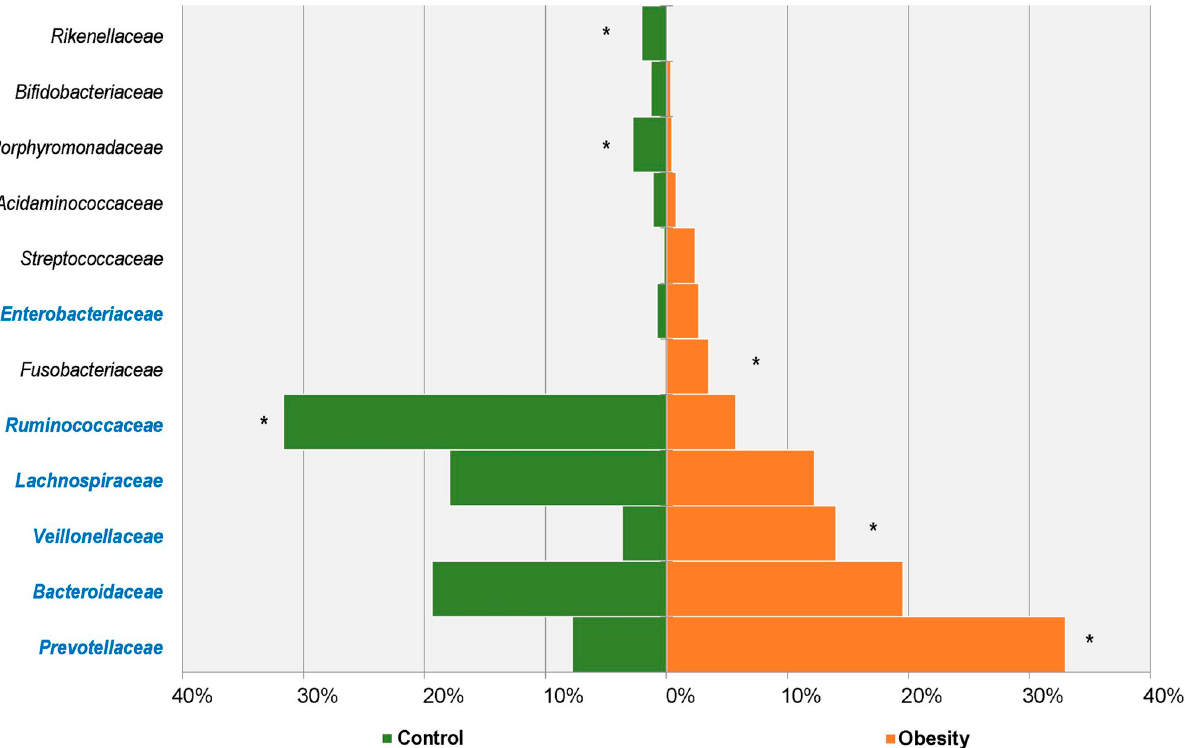
Fig 3. Major abundant families in Obesity and Control groups. The families with significant richness differences between the two groups were labeled with an